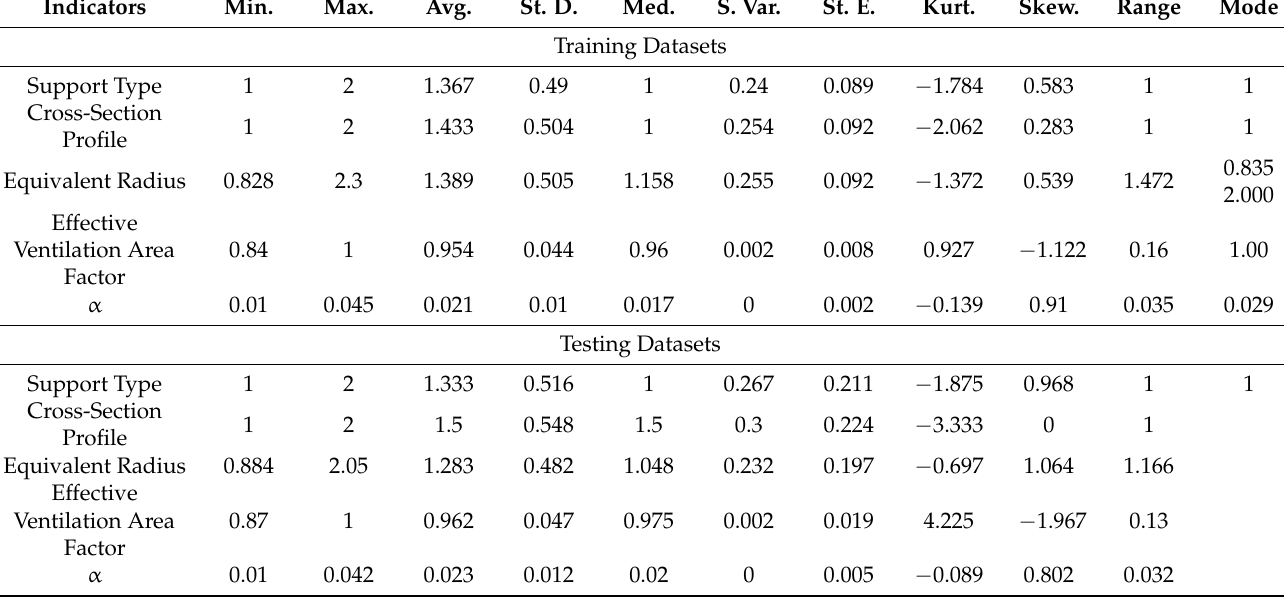
Table 3. Table of the parameter statistics of the active support